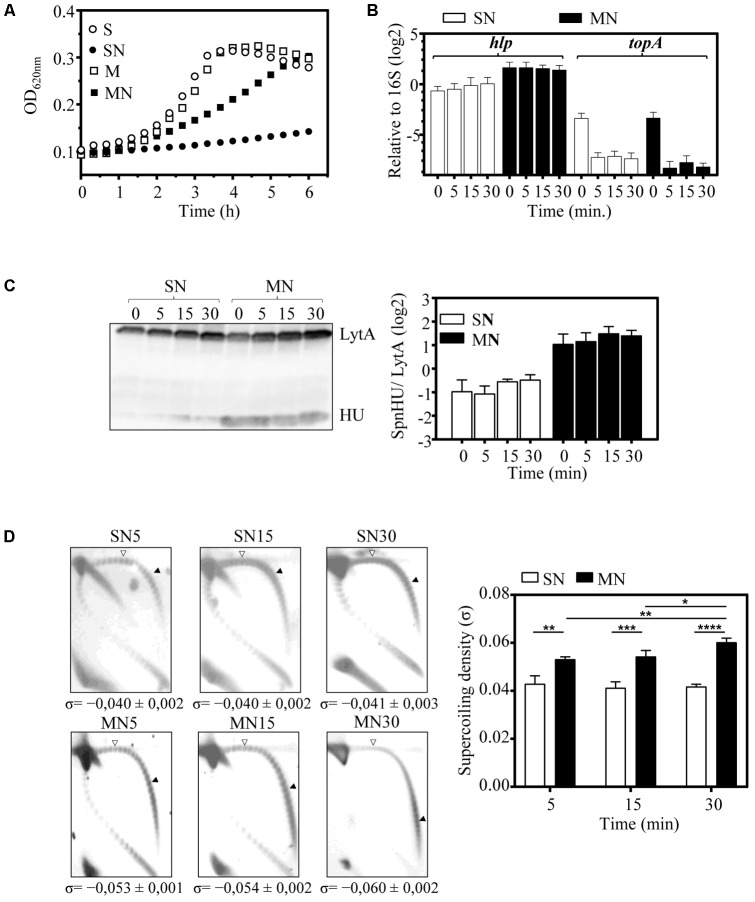
The increase in SpnHU protein levels attenuates the relaxation effect of NOV. A culture of ΔHU (pMVHU) was grown in medium containing sucrose until it reached an OD620
nm= 0.2, and then it was diluted 50-fold in four different media: two containing either sucrose (S), or maltose (M) and two containing either sucrose or maltose, with 1 μg/ml of NOV (SN or MN). Cells were collected 5, 15, and 30 min after addition of the drug. (A) Growth kinetics of ΔHU (pMVHU) cultures. (B) qRT-PCR values of hlp and topA genes relative to those of 16S rDNA after treatment with NOV. Represented values are the average ± SD of three independent replicates. (C) Western blot analysis of SpnHU protein levels in cells exposed to NOV. Crude cell extracts (20 μg) were separated by SDS-PAGE, blotted, and incubated with antibodies directed against SpnHU and LytA. To quantify SpnHU, values were divided by the amount of LytA protein as a loading control. Three independent replicates are represented. (D) Plasmid DNA from cells exposed to NOV at different times was isolated and subjected to 2D agarose gel electrophoresis as described in Section “Materials and Methods.” Supercoiling density (σ) values are averages ± SD from three independent replicates. (∗P < 0.0332, ∗∗P < 0.0021, ∗∗∗P < 0.0002, ∗∗∗∗P < 0.0001).